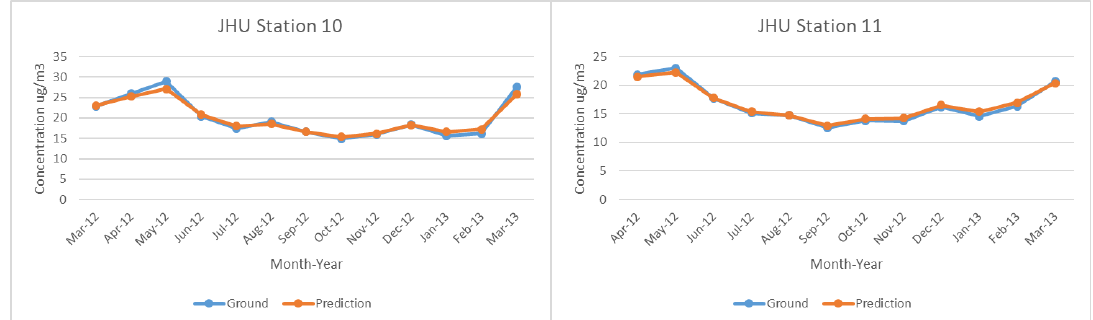
Figure 5. Time series of monthly mean ground measurements and predicted PM 2.5 in µg/m 3 based on random forest model at each monitor station. SENAMHI station names are abbreviated from the name of the location.